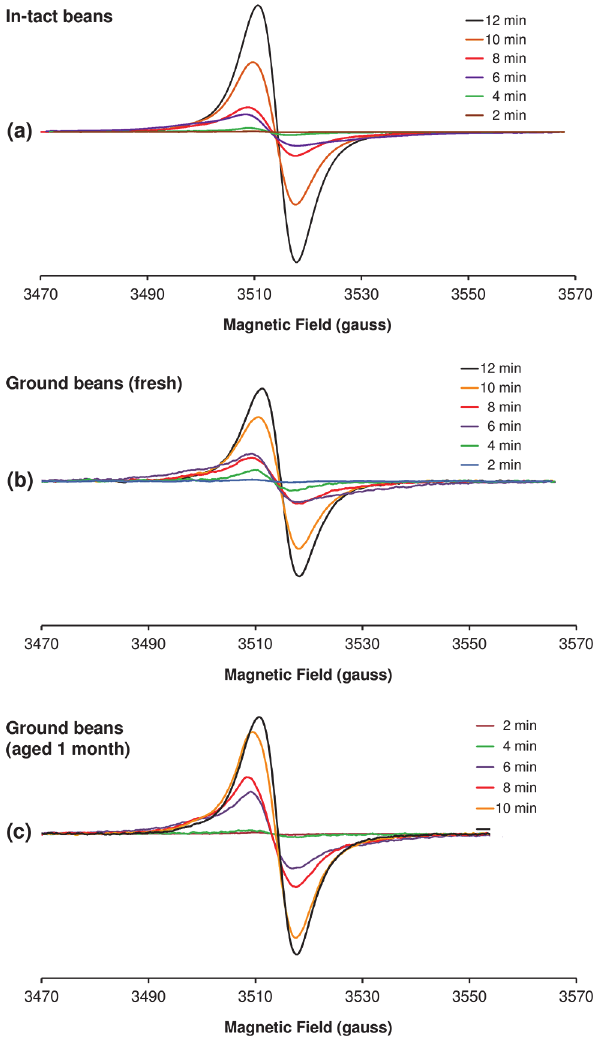
Fig 1. Dependence of the radical EPR spectrum on roasting time in (a) in-tact beans and (b) freshly- ground beans and (c) the same grounds aged 1 month. Data in a represents the average of the double- integrated intensity of EPR spectra obtained from 6 individual beans (S3 Fig) at each roasting time. Experimental conditions: microwave frequency, 9.860 GHz; microwave power, 0.1 mW; magnetic field modulation amplitude, ( a ) 3 G, ( b , c ) 1 G; field modulation frequency, 100 kHz; receiver time constant, 164 ms; receiver gain, ( a ) 60 dB, ( b , c ) 66 dB; sweep rate, 4 G/s; averages, 1. The intensity in b-c is directly comparable, whereas the intensity in a is not directly comparable with b-c